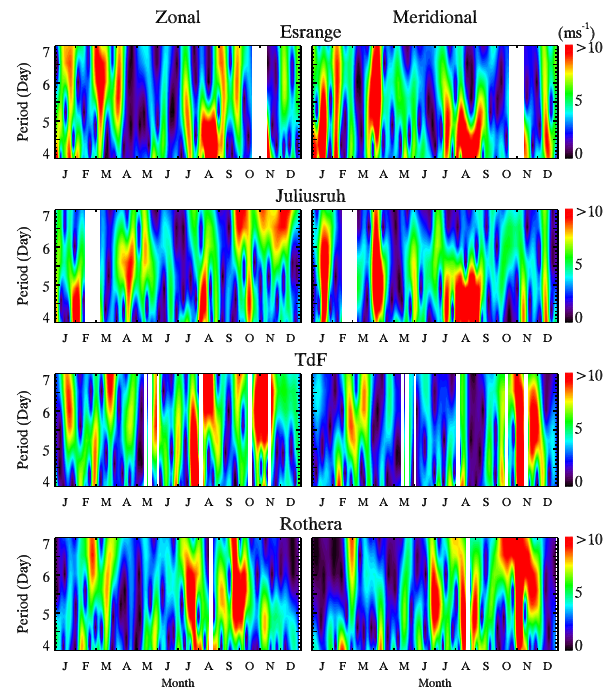
Figure 1. S-transform amplitudes for periods between 4 and 7days from hourly mean zonal (left) and meridional (right) winds at 90km for 2012. Esrange, Juliusruh, Tierra del Fuego, and Rothera are from top to